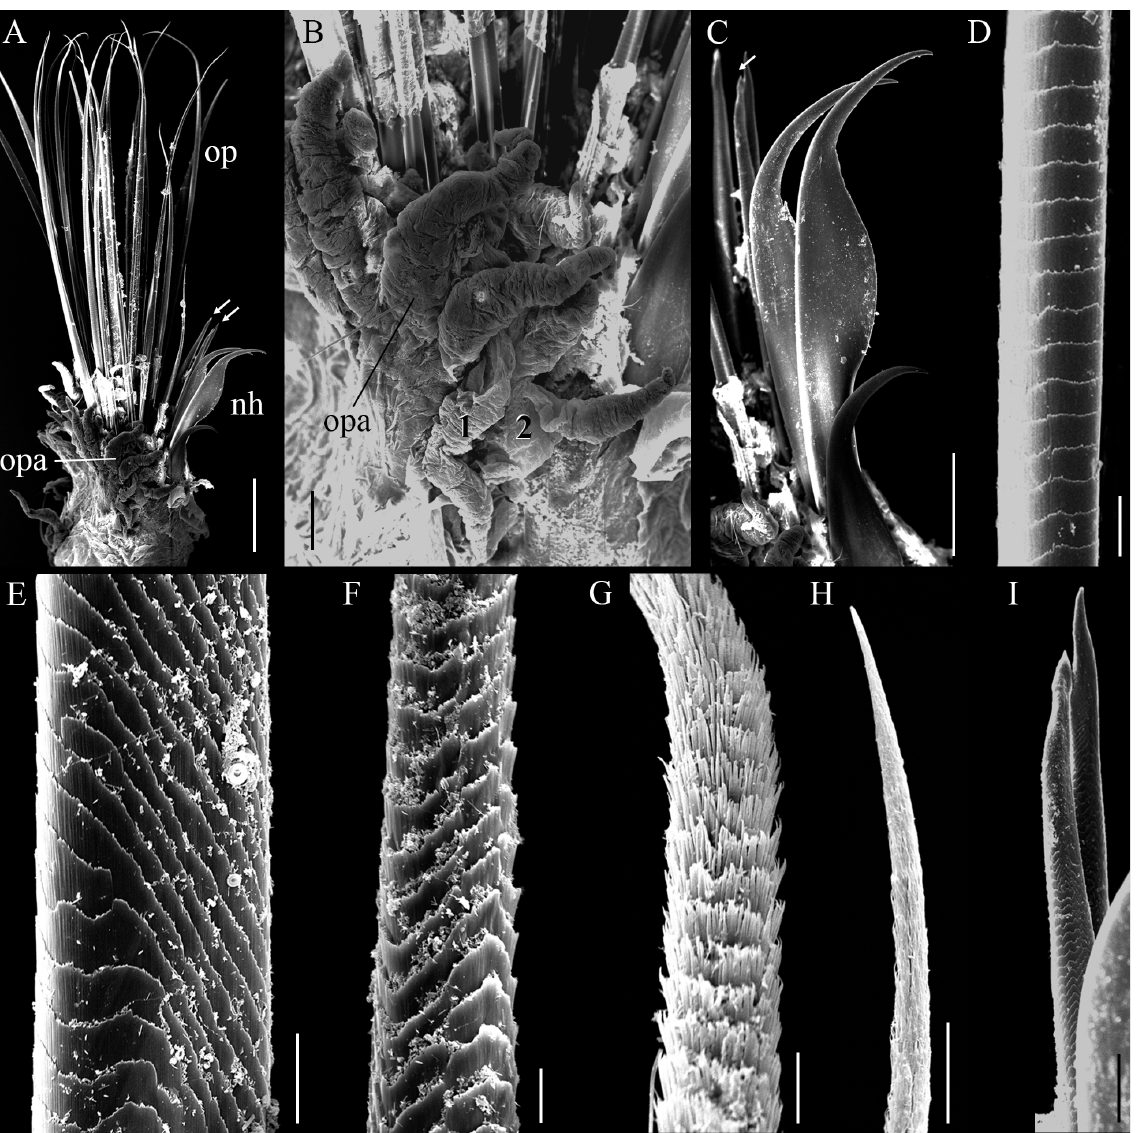
Fig. 15. Phalacrostemma perkinsi Kirtley, 1994 (UMML-22.1192). A . Left opercular lobe. B . Detail of two rows of opercular papillae. C . Nuchal hooks. D–H . Outer palea. D . Proximal region. E . Proximal- middle region. F . Middle region. G . Middle-distal region. H . Tip. I . Inner paleae. Abbreviations: nh = nuchal hooks; op = outer paleae; opa = opercular papillae. Arrows indicate inner paleae. Numbers indicate the rows of opercular papillae. Scale bars: A = 0.5 mm; B = 100 µm; C = 200 µm; D–E, H = 20 µm; F–G = 10 µm; I = 50